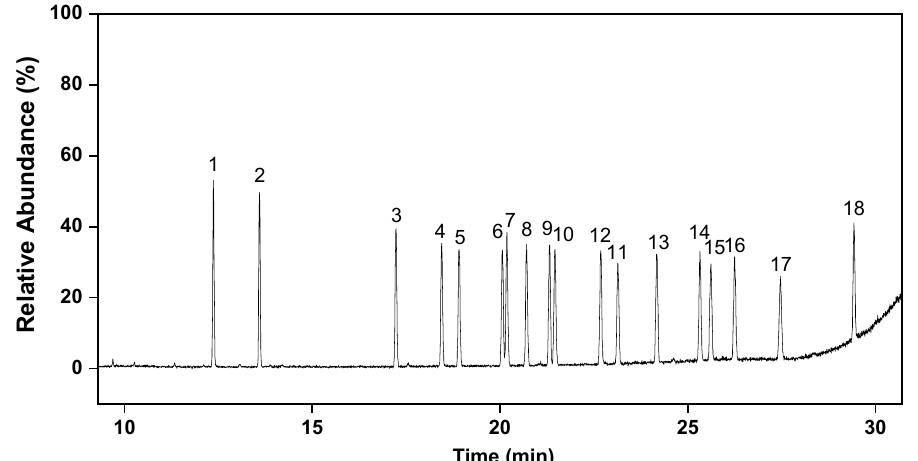
Figure 1. Total ion chromatogram of the 18 PCB standard solutions at 500 µ g/L. Peak identification: